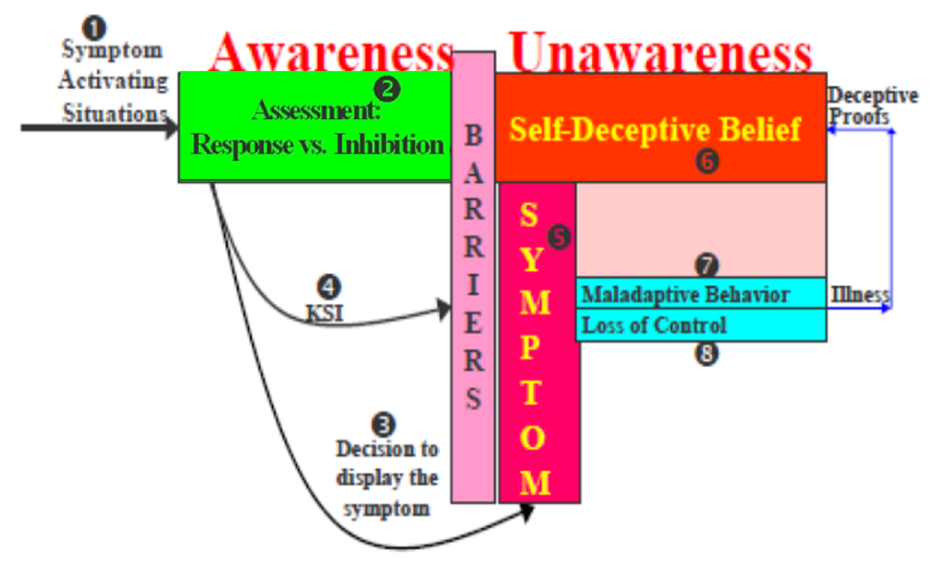
Figure 1. The dececptive